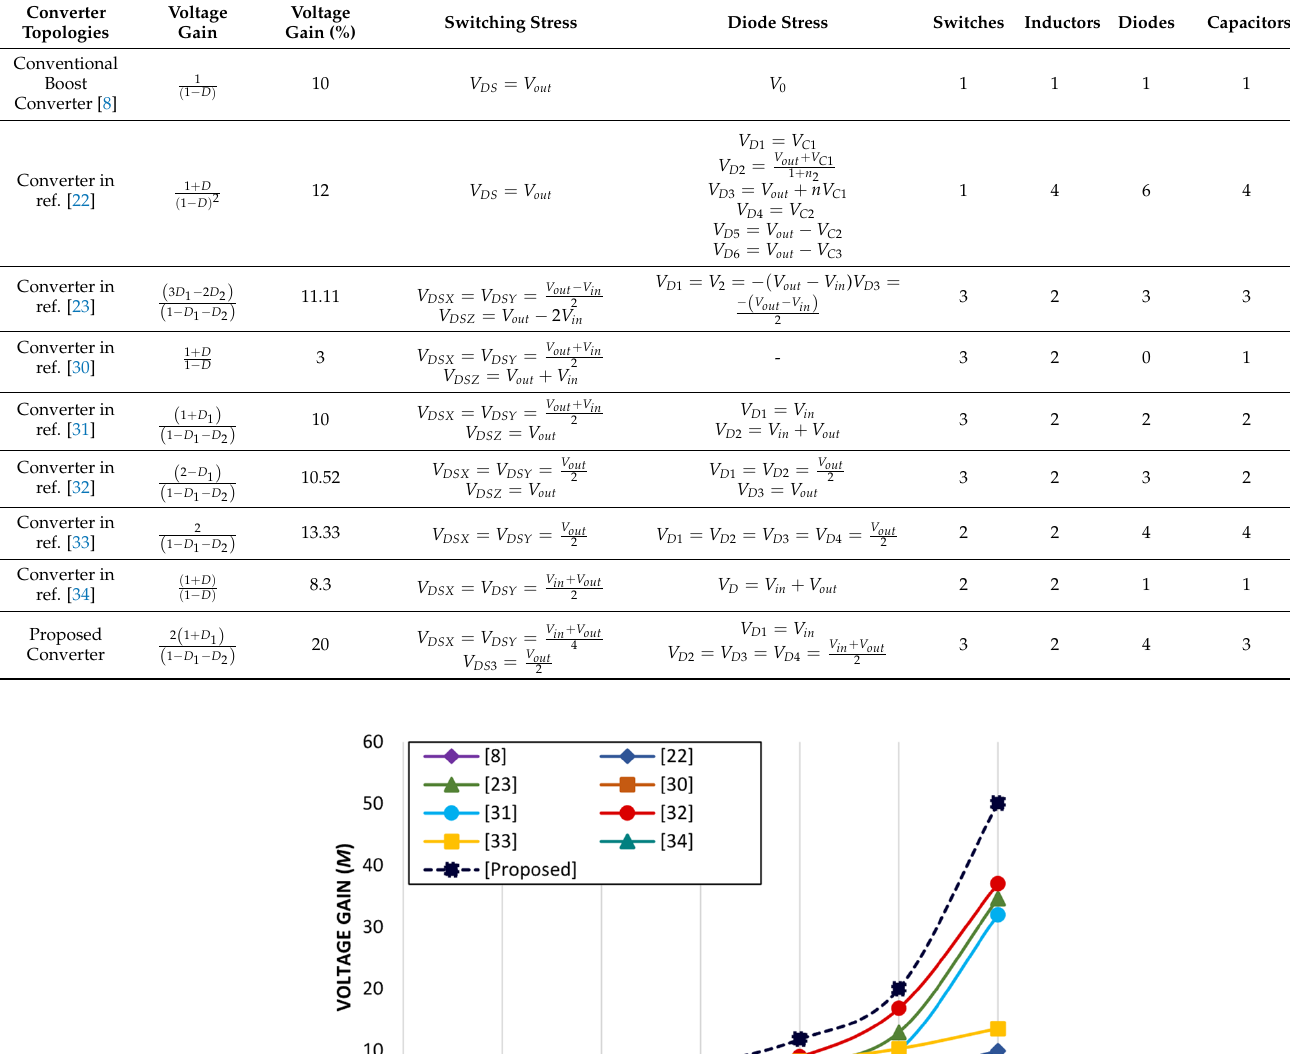
Table 1. Steady-state analysis and the component count comparison.